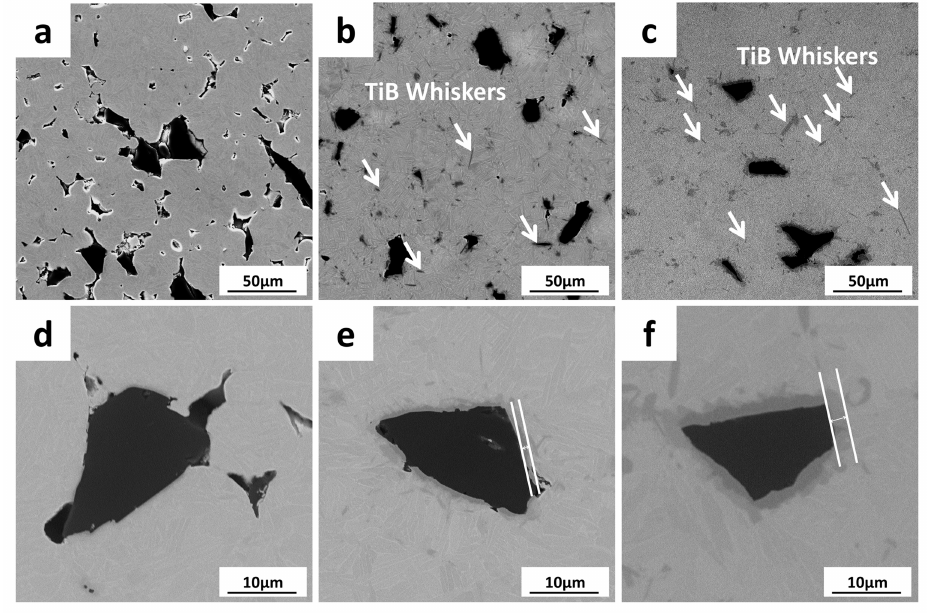
Figure 3. The microscopic morphology of TMCs with C-B addition sintered at different temperatures. ( a ) and ( d ) 900 ◦ C; ( b ) and ( e ) 1000 ◦ C; ( c ) and ( f ) 1100 ◦ C.